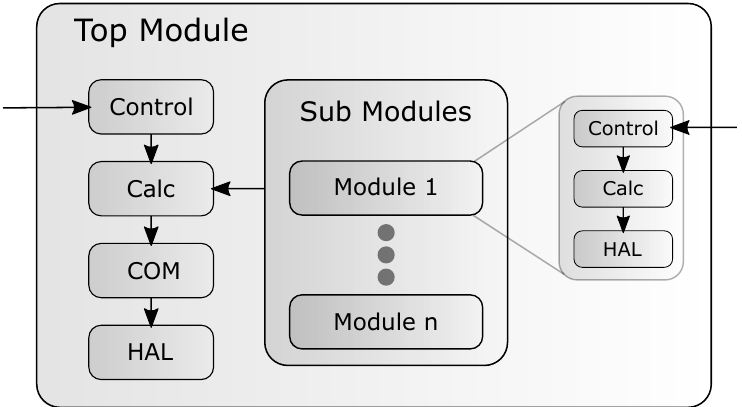
Figure 1. Conceptual structure of the sensor power